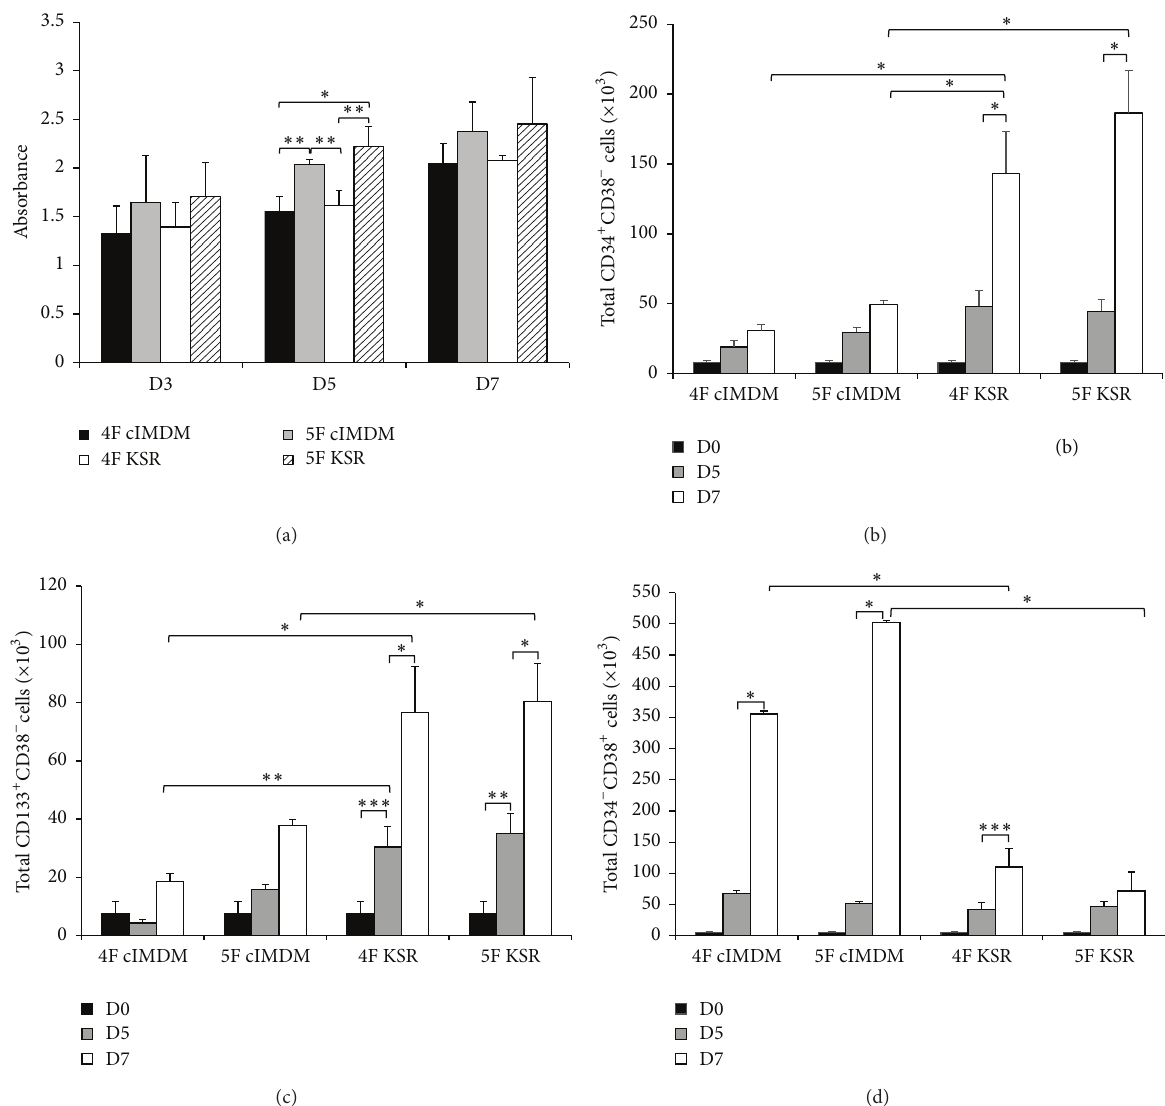
Figure 1: Proliferation of expanded CB cells. CB-CD34 + were maintained in 4 different cultures media: 2 serum-containing media (4F cIMDM, 5F cIMDM) and 2 serum-free media (4F KSR, 5F KSR). (a) Proliferation assay, (b) growth profile of total CD34 + CD38 − cells, (c) CD133 + CD38 − cells, and (d) CD34 − CD38 + cells. After culturing the cells for 5 and 7 days, cells were harvested for analysis and normalized with day 0 ( 𝑛 = 3 ). ∗ 𝑃 < 0.001 , ∗∗ 𝑃 < 0.02 , and ∗∗∗ 𝑃 < 0.05